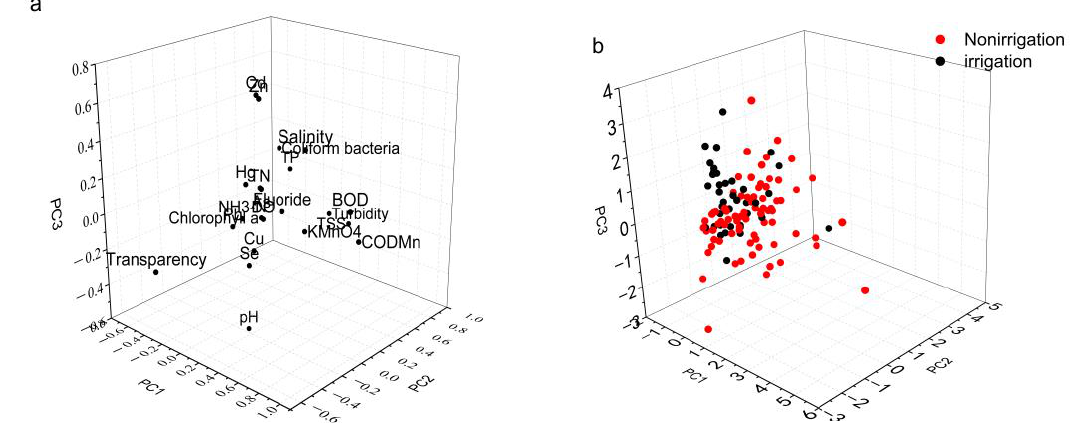
Figure 2. Factor score and loading plot of Principal Component Analysis (PCA) for water quality factors ( a ) and irrigation periods ( b ).